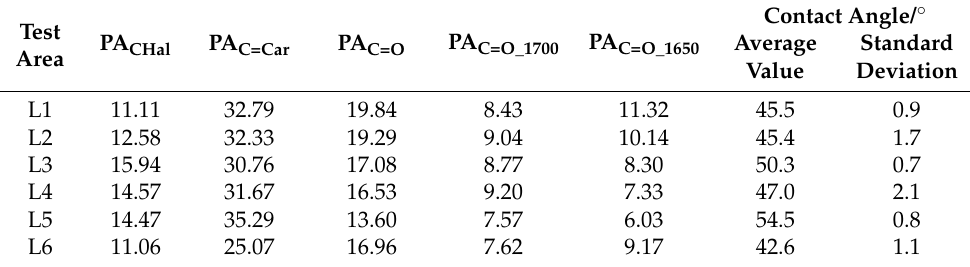
Table 2. Contact angle and micro-FTIR results of different testing